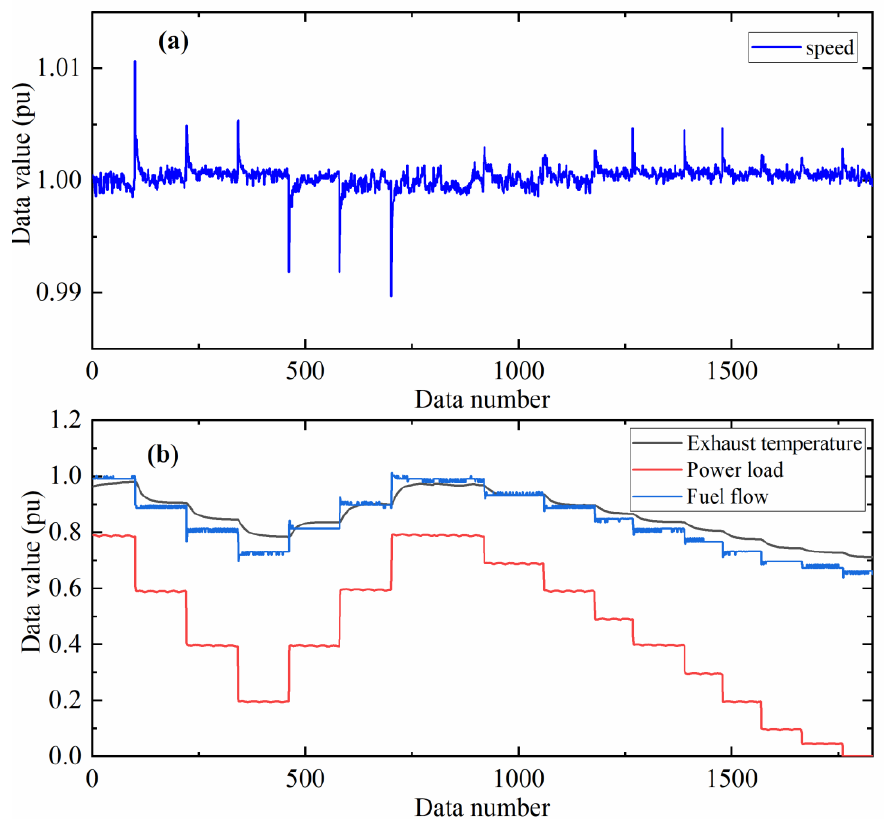
Figure 8. Gas turbine model training data set: ( a ) Speed signal; ( b ) Exhaust temperature, fuel flow and power load signals.